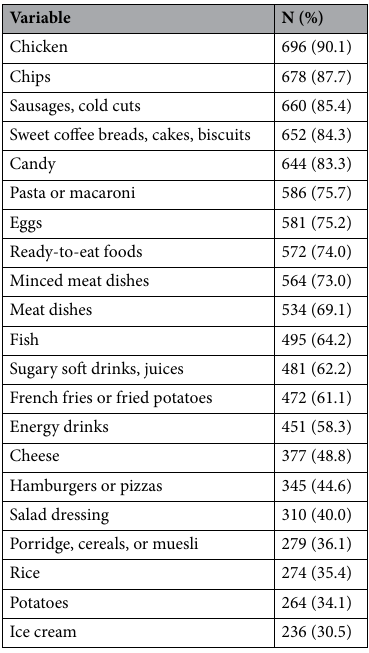
Table 3. Frequencies of weekly intake of food and